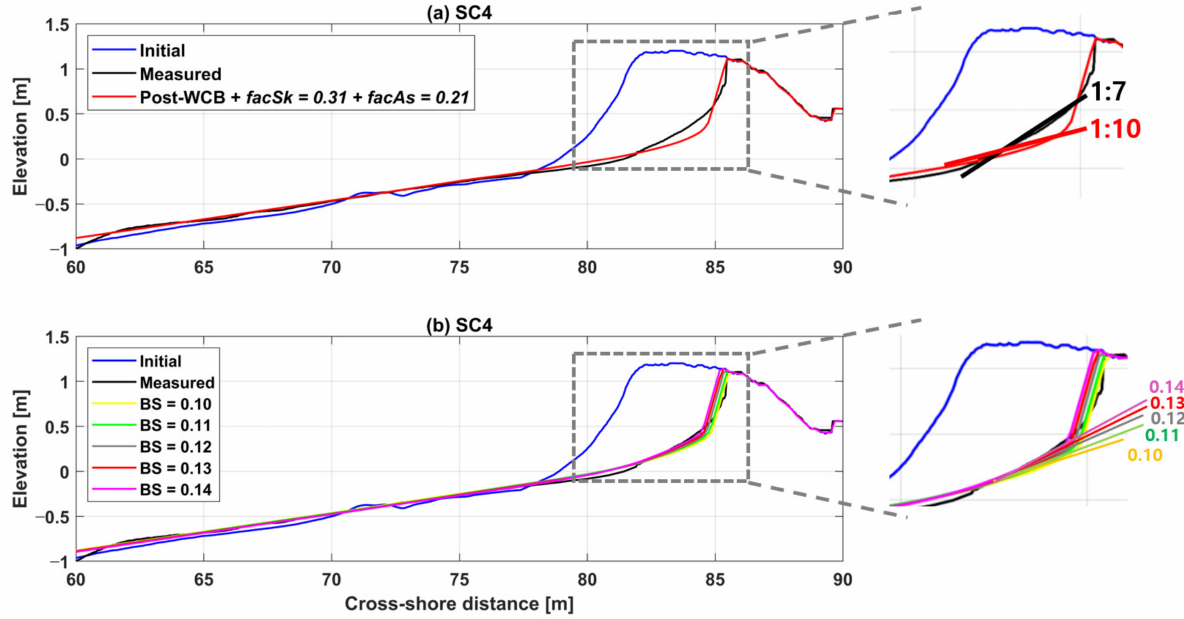
Figure 7. Initial, measured, and computed final profile for SC4: ( a ) slope of swash zone: measured profile (1:7) and computed profile (1:10); ( b ) bermslope (BS)